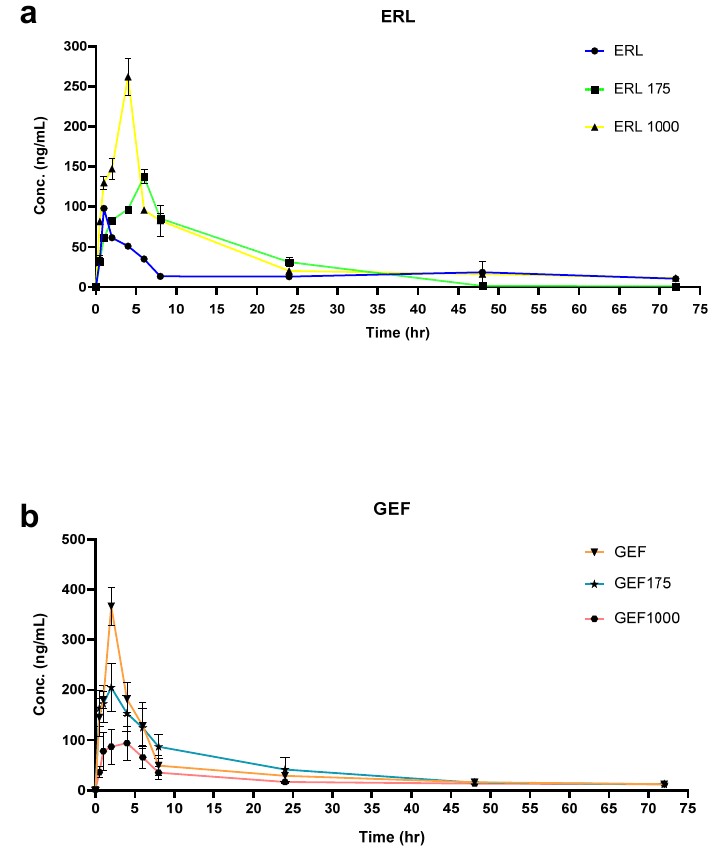
Figure 6. Plasma concentration–time curve after oral administration of ERL (20 mg/kg) ( a ); and GEF (20 mg/kg) ( b ) in rat receiving 175 and 1000 mg ASP ( n =